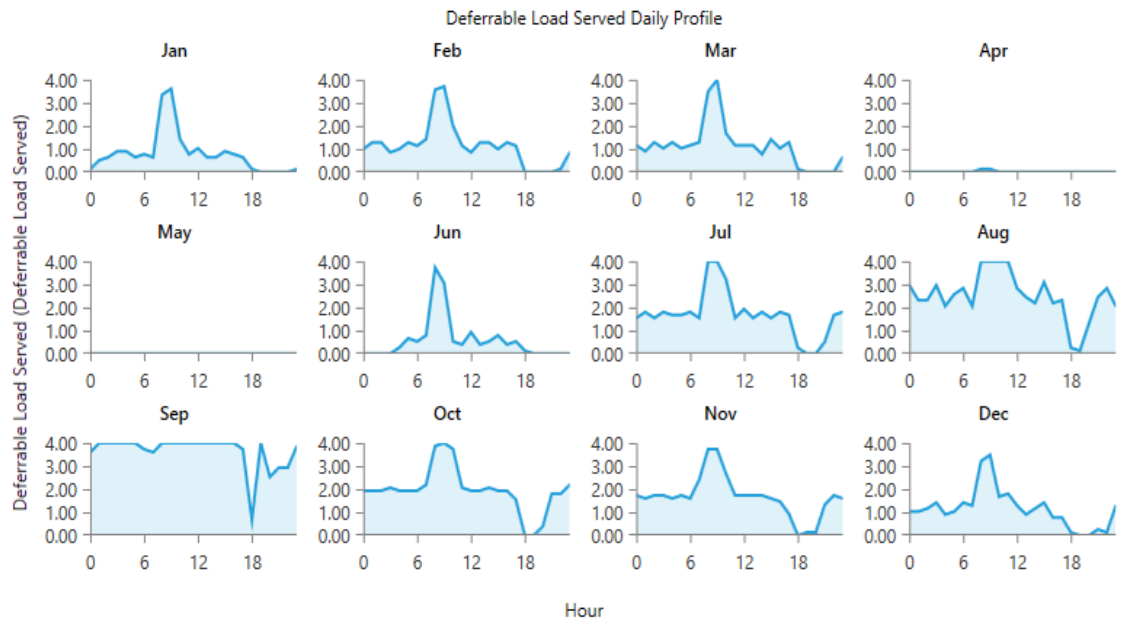
Figure 16. Electric load served (daily profile) at Site 12.